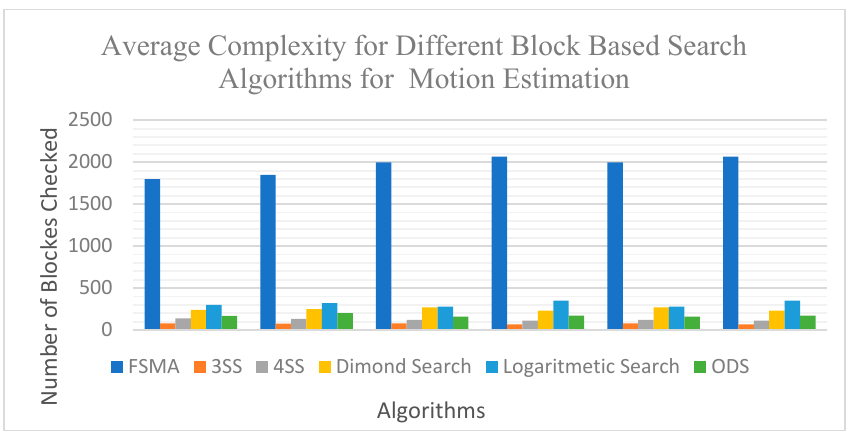
Figure 14. Average computational complexity for different block-based search algorithms for temporal analysis.